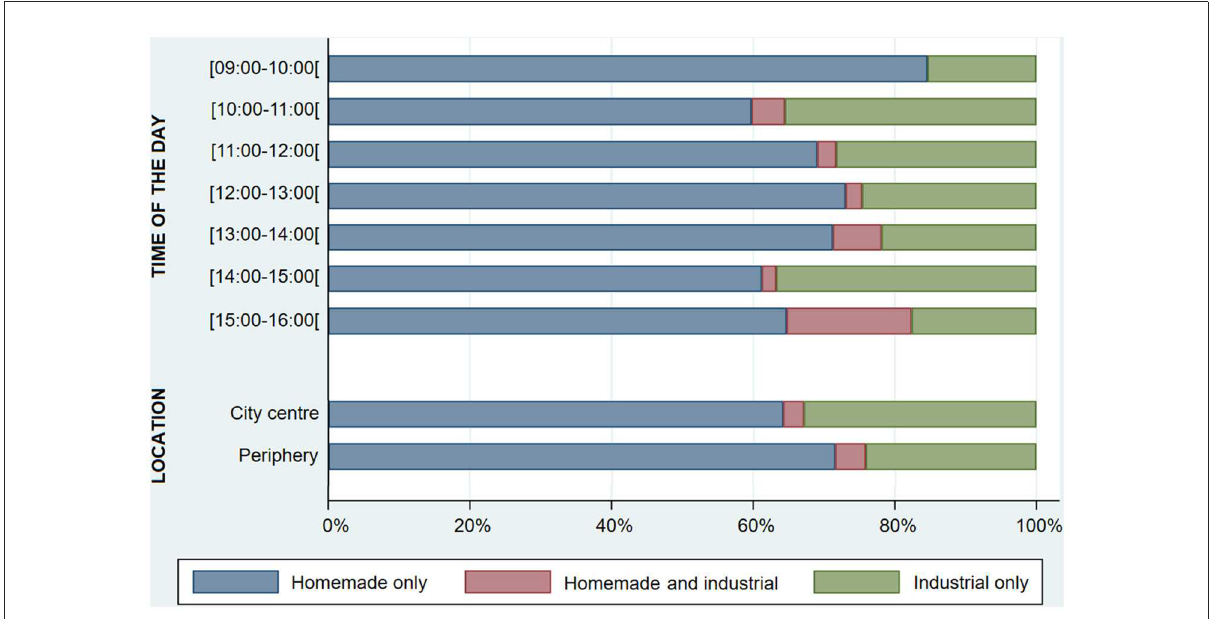
FIGURE5 Proportion of customers purchasing homemade and/or industrial food items, throughout the day and by city location ( n =